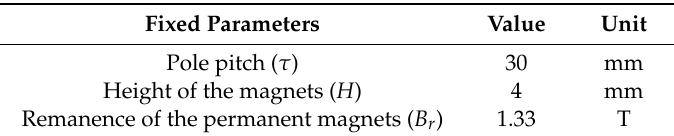
Table 1. Fixed parameters of the novel magnet array.